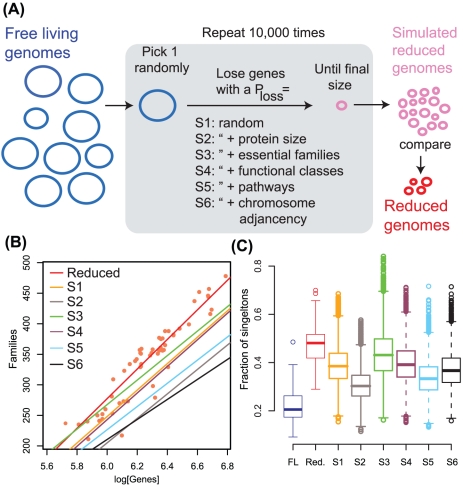
Selective loss of paralogy.(A) Cartoon illustrating the simulation of gene loss according to different scenarios. (B) Protein family diversity is higher in Reduced genomes than in the simulated reduced genomes. Individual genomes (open circles) and the logarithmic fit for the Reduced genomes is shown in red. Only the logarithmic fit is shown for each simulation (r2
S1 = 0.91; r2
S2 = 0.84; r2
S3 = 0.93; r2
S4 = 0.91, r2
S5 = 0.86; r2
S6 = 0.89). The slopes of the fits are significantly lower than those of the Reduced genomes (p
S1 = 0.006, p
S2 = 2.1×10−4, p
S3 = 1.6×10−7, p
S4 = 0.003, p
S5 = 2.82×10−17, p
S6 = 3.08×10−9 t-test) (C) The plot shows the relative frequency of singletons in FL, Reduced and simulated genomes. Reduced genomes have more singletons than could be expected under any of the simulated scenarios (pS1 = 0.002, pS2 = 0.0004, pS3 = 0.005, pS4 = 0.002, pS5 = 0.0008, pS6 = 0.002, Mann-Whitney U test).